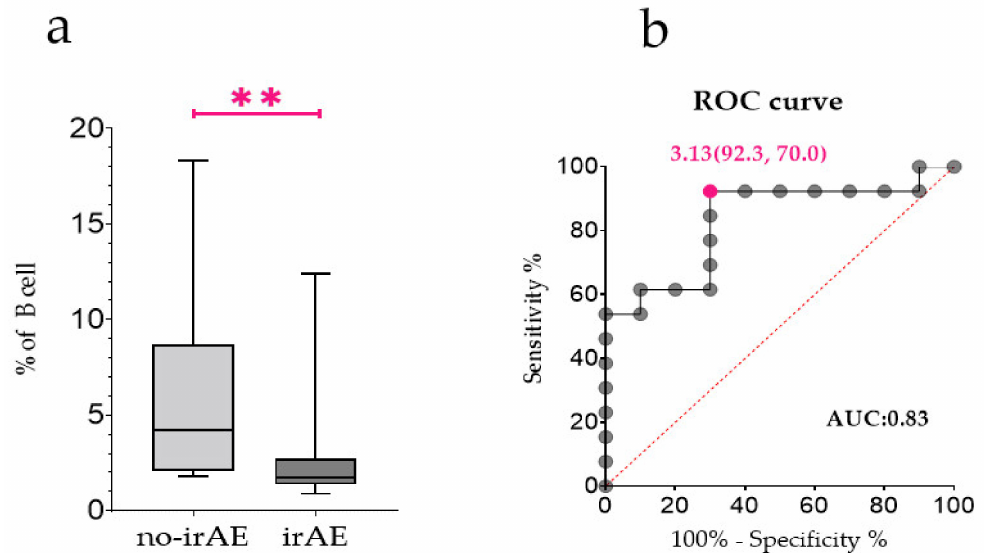
Figure 3. The proportion of CD21 lo B cells at the baseline. ( a ) Comparison between no-immune- related adverse event (irAE) group ( n = 10) and irAE group ( n = 13) for percentages of CD21 lo B cells among B cells at baseline. ( b ) Receiver operating characteristic curve showing utility of CD21 lo B cells at baseline for predicting the risk of irAEs in patients. ** p < 0.01 by two-tailed Wilcoxon signed-rank